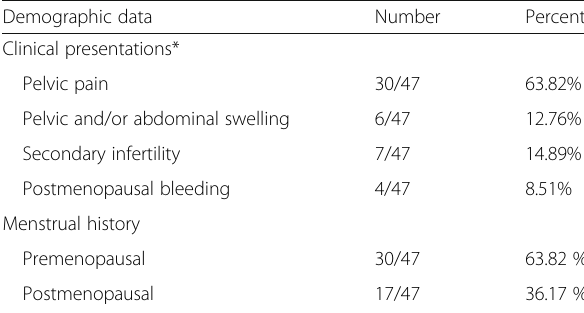
Table 2 Demographic data and clinical presentation of the patient ’ s cohort